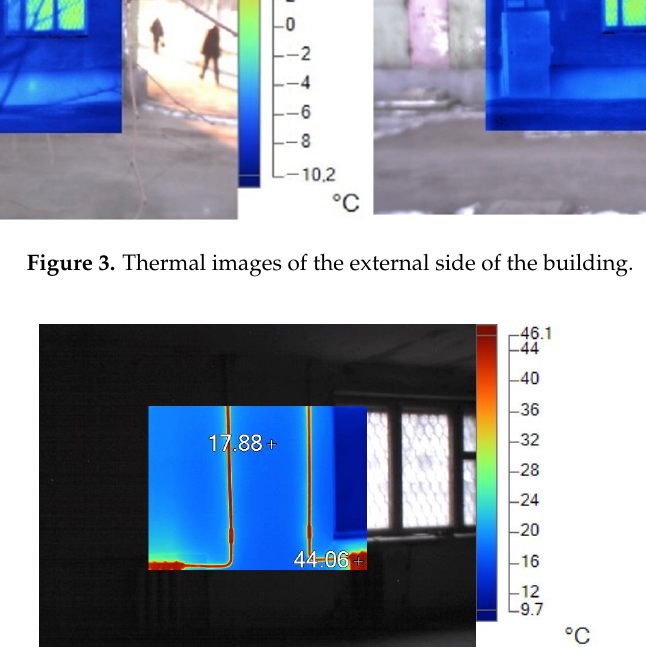
Figure 4. Thermal images of the external side of the building before installing heat flux sensors.